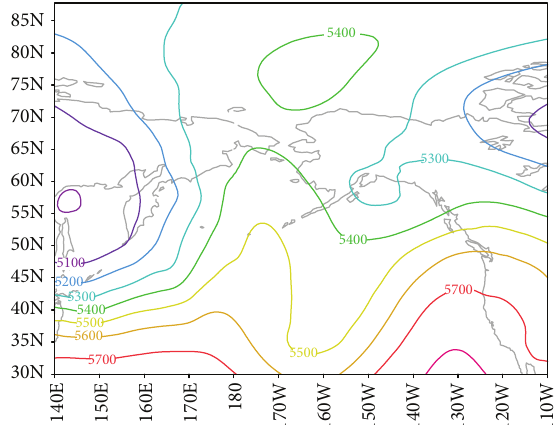
Figure 7: ERA-Interim reanalysis time-averaged geopotential heights for March 9–14, 2013.